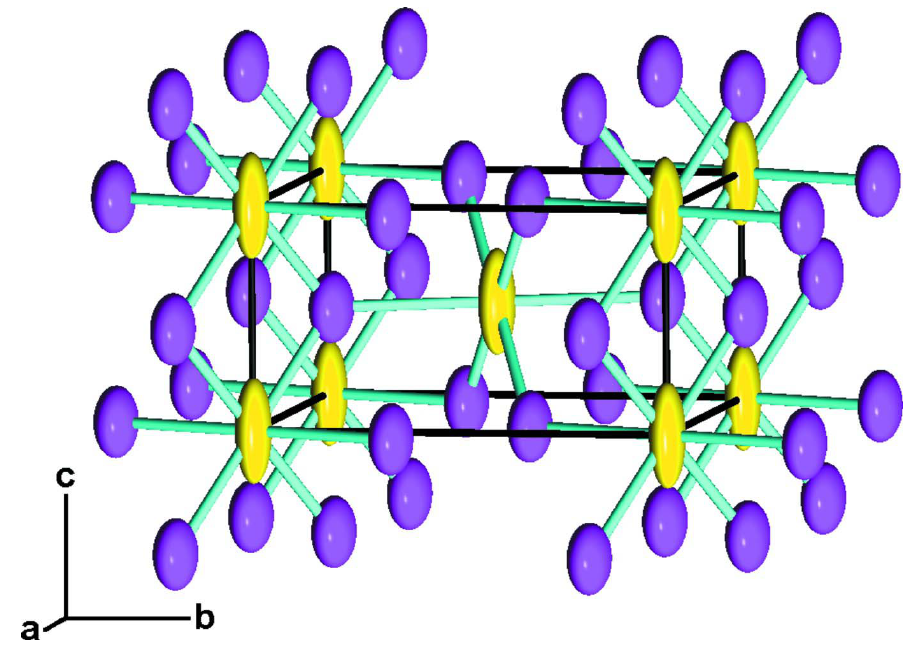
Figure 1 Crystal structure of safflorite, with displacement ellipsoids drawn at the 99.9% probabiliy level. The M (=Co+Ni+Fe) cations (yellow spheres) are situated in octahedra coordinated by six As atoms (pink